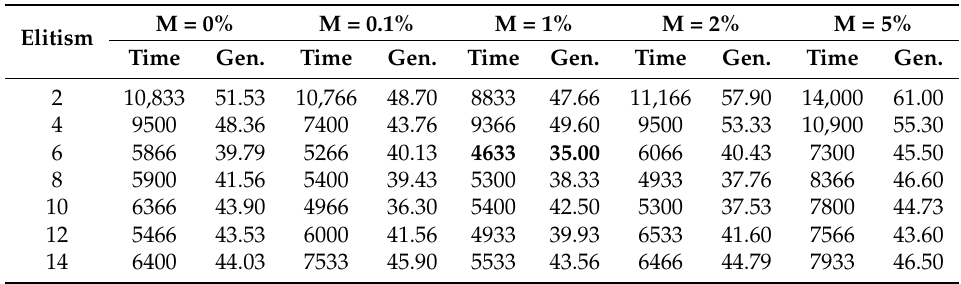
Table 3. Results of different elitism sizes, for a population of 25 individuals. M is the mutation rate, Gen. the number of